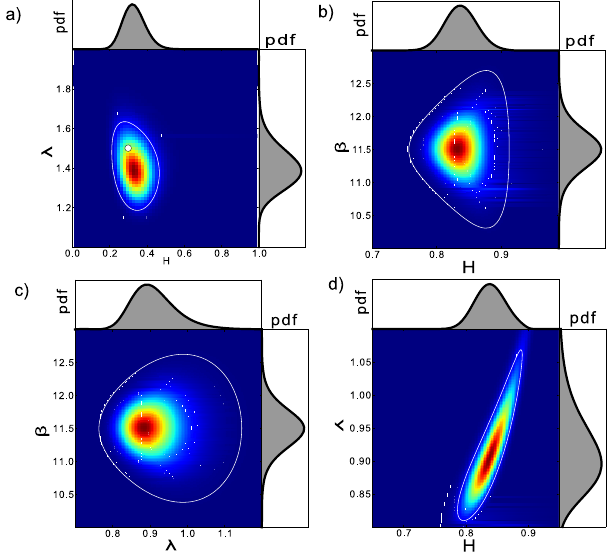
Fig. 6. Normalized two dimensional marginal posterior densities. The maxima indicate the most likely estimates in: (a) H − λ plain for signal X n = 1 . 5 G 0 . 3 n + 8 . 0 , n = 1 ,...,N = 100. Note that the posterior is well localized around the point corresponding to the true value (white spot); (b) H − β plain for Nile River; (c) λ − β plain for Nile River; (d) H − λ plain for Nile River; on the axis, the one dimensional projections of the posterior densities are depicted. The white contour-line encloses 90% of posterior probability. It there- fore quantifies the posterior uncertainty of the parameters together with their posterior